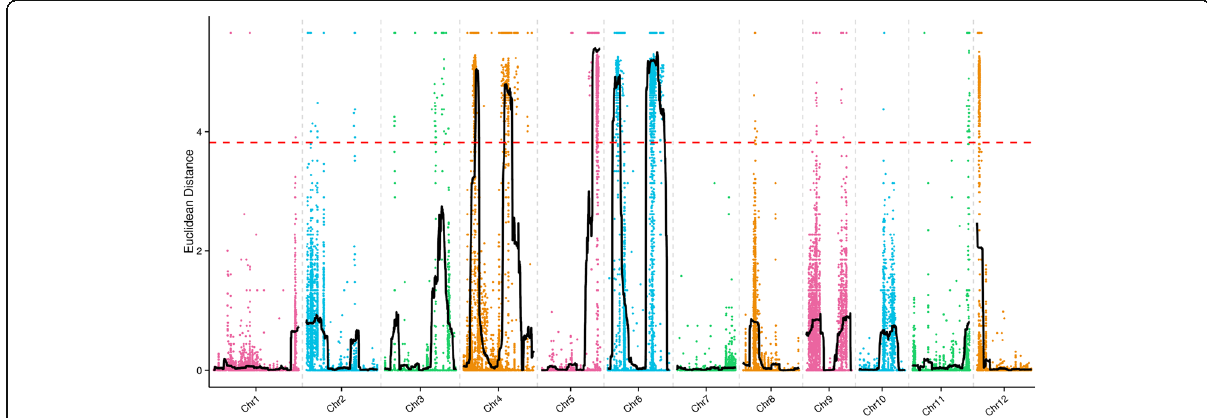
Fig. 2 Identification of the hot-region for PSST through the ED association analysis method. X-axis represents the position of 12 chromosomes of rice and Y-axis represents the ED. The color dots represent the ED value of every SNP locus. The black lines show the ED value of fitting results, and the red imaginary lines show the association threshold of ED